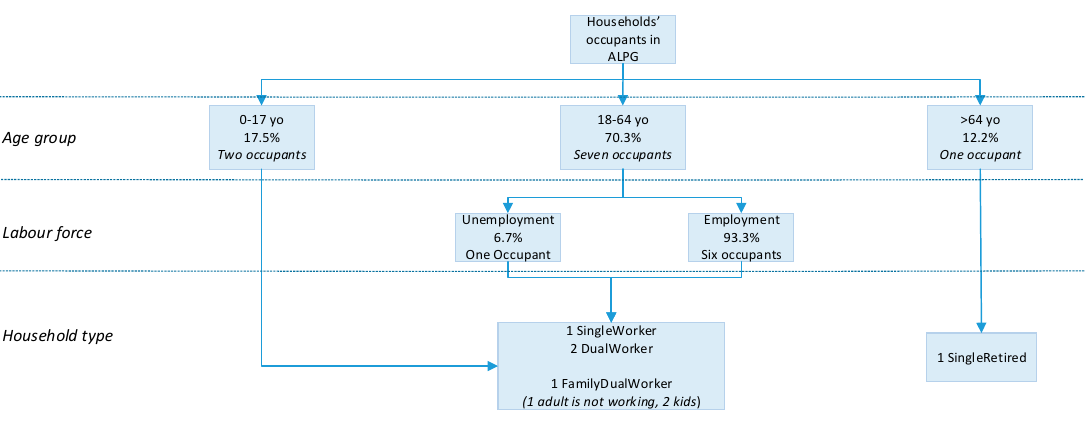
Figure 8. The application of the Wepro model’s structure for Amsterdam’s household occupancy profiles in ALPG. It consists of the Amsterdam’s age group share, labour force composition share and gender share of each age group, their capacity of the occupants to be modelled and the selected pre-defined profiles provided in LPG.